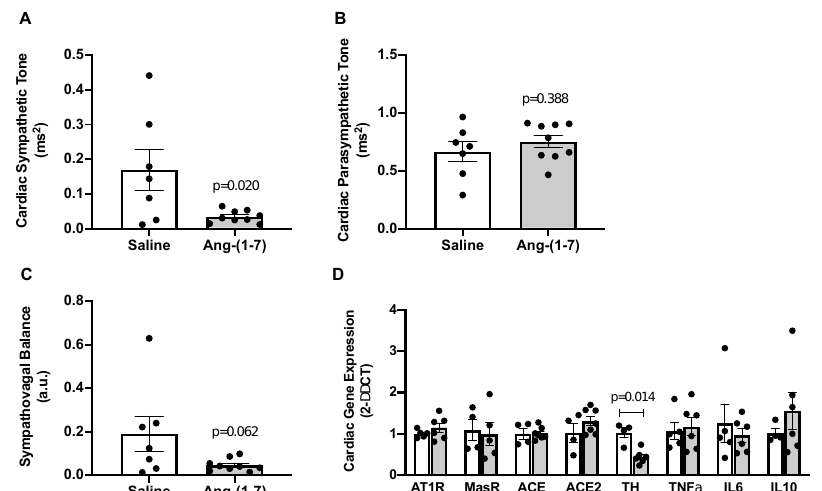
Figure 4. Angiotensin (Ang)-(1-7) decreased measures of cardiac sympathetic tone in aged mice. ( A– C ) . Indices of cardiac sympathetic and parasympathetic tone measured by spectral analysis of low- frequency and high-frequency components of heart rate variability, respectively ( n = 7–9/group). Ang- (1-7) reduced cardiac sympathetic tone, with no effect on parasympathetic tone, in aged mice. This resulted in a trend for Ang-(1-7) to improve overall cardiac sympathovagal balance in aged mice. ( D ), Gene expression measured in hearts from saline- versus Ang-(1-7)-treated aged mice using quantitative real-time PCR methods ( n = 4–6/group). Ang-(1-7) reduced cardiac mRNA of tyrosine hydroxylase (TH), the rate-limiting enzyme for norepinephrine synthesis, in the heart of aged mice. There was no effect of Ang-(1-7) on cardiac mRNA for markers of the renin–angiotensin system (AT1R, Ang II AT1 receptor; MasR, Ang-(1-7) Mas receptor; ACE, angiotensin-converting enzyme; ACE2, angiotensin-converting enzyme 2) or inflammatory markers (TNFα, tumor necrosis factor α; IL6, interleukin 6; IL10, interleukin 10). Data are mean ± SEM and were analyzed by an unpaired t - test. 3. Discussion Despite numerous studies showing protective cardiometabolic effects in young animals [6,17,18], there are few studies examining Ang-(1-7) actions in aged animals. The goal of this study was to determine whether chronic Ang-(1-7) treatment improved age-related cardiovascular and metabolic deterioration. The main findings in aged mice are as follows: (1) a cardiometabolic phenotype similar to aging in clinical populations was observed including the increased body mass and adiposity, hyperinsulinemia, insulin resistance, cardiac hypertrophy, elevated blood pressure, and reduced heart rate; (2) Ang-(1-7) infusion for six weeks improved measures of integrated cardiometabolic function, specifically systolic and mean blood pressure and insulin sensitivity; (3) Ang-(1-7)-mediated improvements in blood pressure and insulin sensitivity were independent of changes in body mass, body composition, and cardiac hypertrophy; and (4) blood pressure-lowering effects of Ang-(1-7) were associated with reduced measures of sympathetic tone to the heart, in the absence of changes in local RAS and inflammatory markers. These overall data indicated that Ang- (1-7) may provide a novel target to reverse age-related cardiovascular and metabolic complications. To our knowledge, this is the first report describing effects of Ang-(1-7) on cardiometabolic outcomes in aged animal models. Therefore, while descriptive in nature, this study adds to the very limited literature on Ang-(1-7) in aging and provides a rationale for further research to identify precise mechanisms underlying these beneficial effects. Healthy aging is known to alter activity and responsiveness of the RAS. Plasma renin activity and responsiveness and aldosterone and Ang II levels are decreased in aged animals and clinical populations [7,8]. Ang II elicits exaggerated responses in aged animals, however, due to the increased